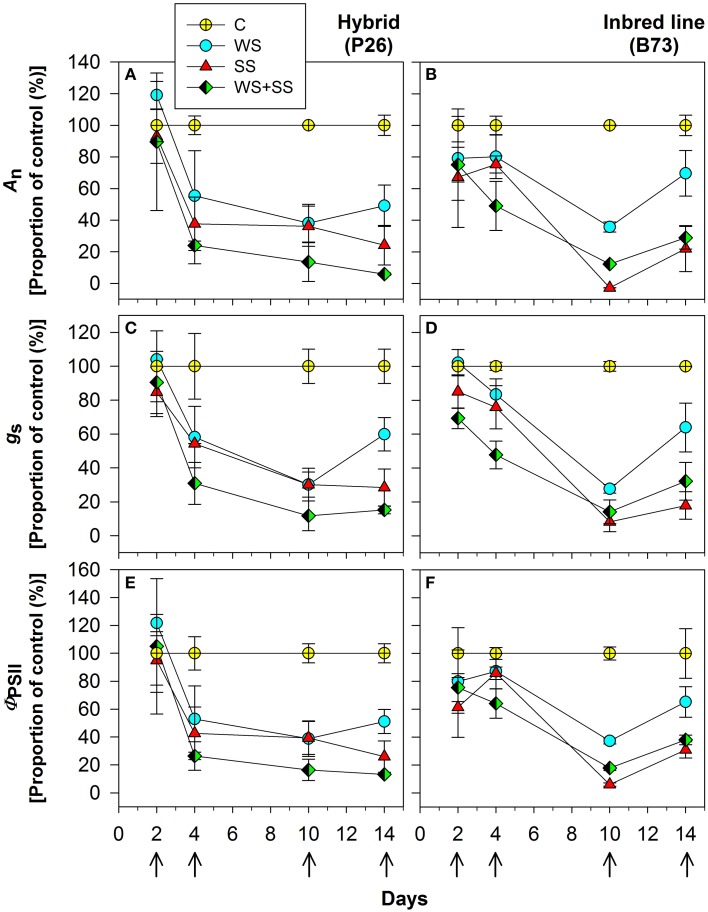
Effect of water stress (WS), salt stress (SS), and their combination (WS+SS) on the (A,B) net CO2 assimilation (An) and (C,D) stomatal conductance (gs) and (E,F) PSII quantum efficiency (ΦPSII) for P26 (left) and B73 (right) genotype plants. Average ± SE values of An, gs, and ΦPSII are expressed as a proportion of the control. Arrows represent sampling times throughout the experimental period.